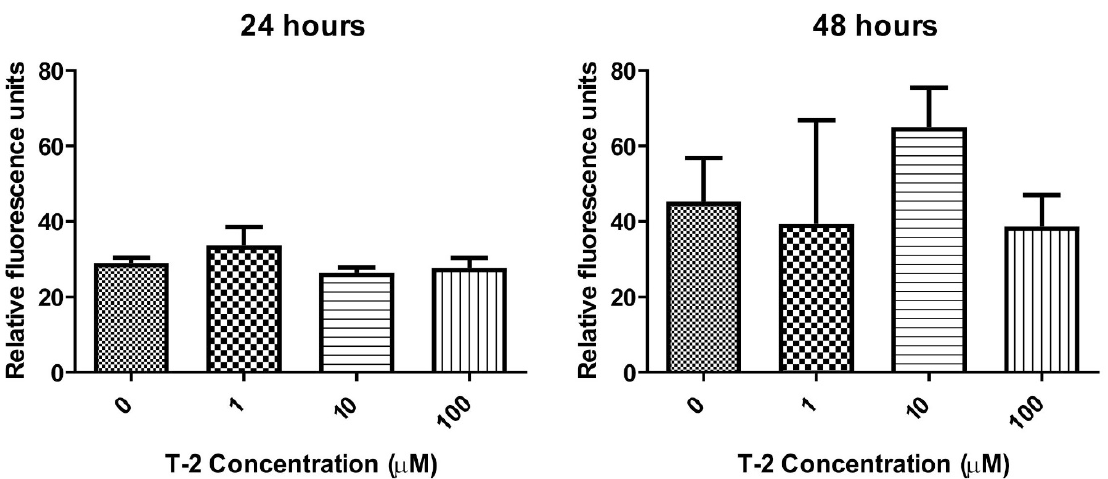
Figure 5. The T-2 effect on the caspase 3/7 pathway activation in Hs68 cells. Caspases’ proteolytic activity was measured by fluorescence of 485 nm/538 nm after 24 h and 48 h incubation with the toxin, respectively. Values means ± SD ( n = 6). 0: untreated (control) cells; 1: concentration of toxin—1 µM; 10: concentration of toxin—10 µM; 100: concentration of toxin—100 µM.